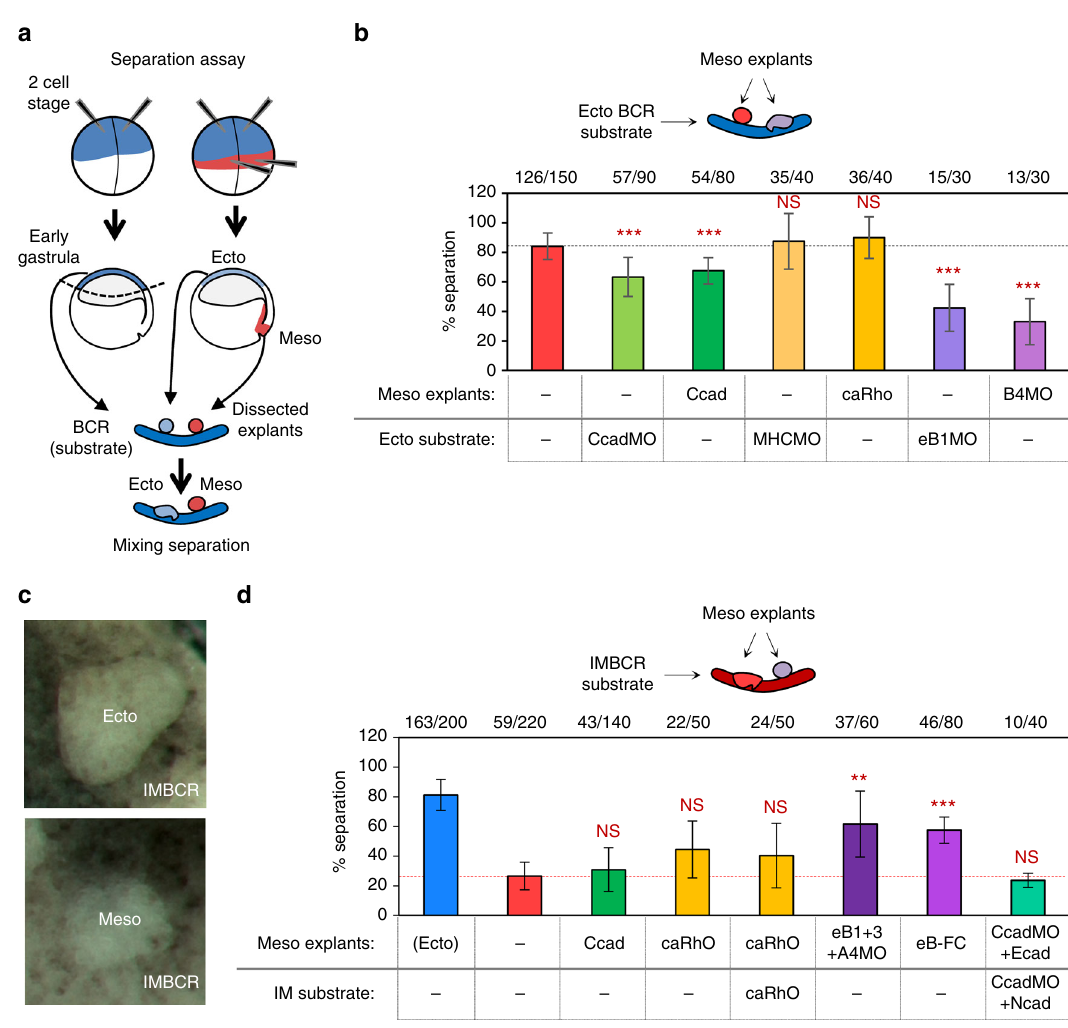
Fig. 4 Impact of adhesive and contractile difference on ectoderm – mesoderm separation. a Scheme of the separation assay. Embryos injected at the 2 cell-stage were dissected at the early gastrula stage. Explants were laid on a BCR, and the number of explants remaining separated were